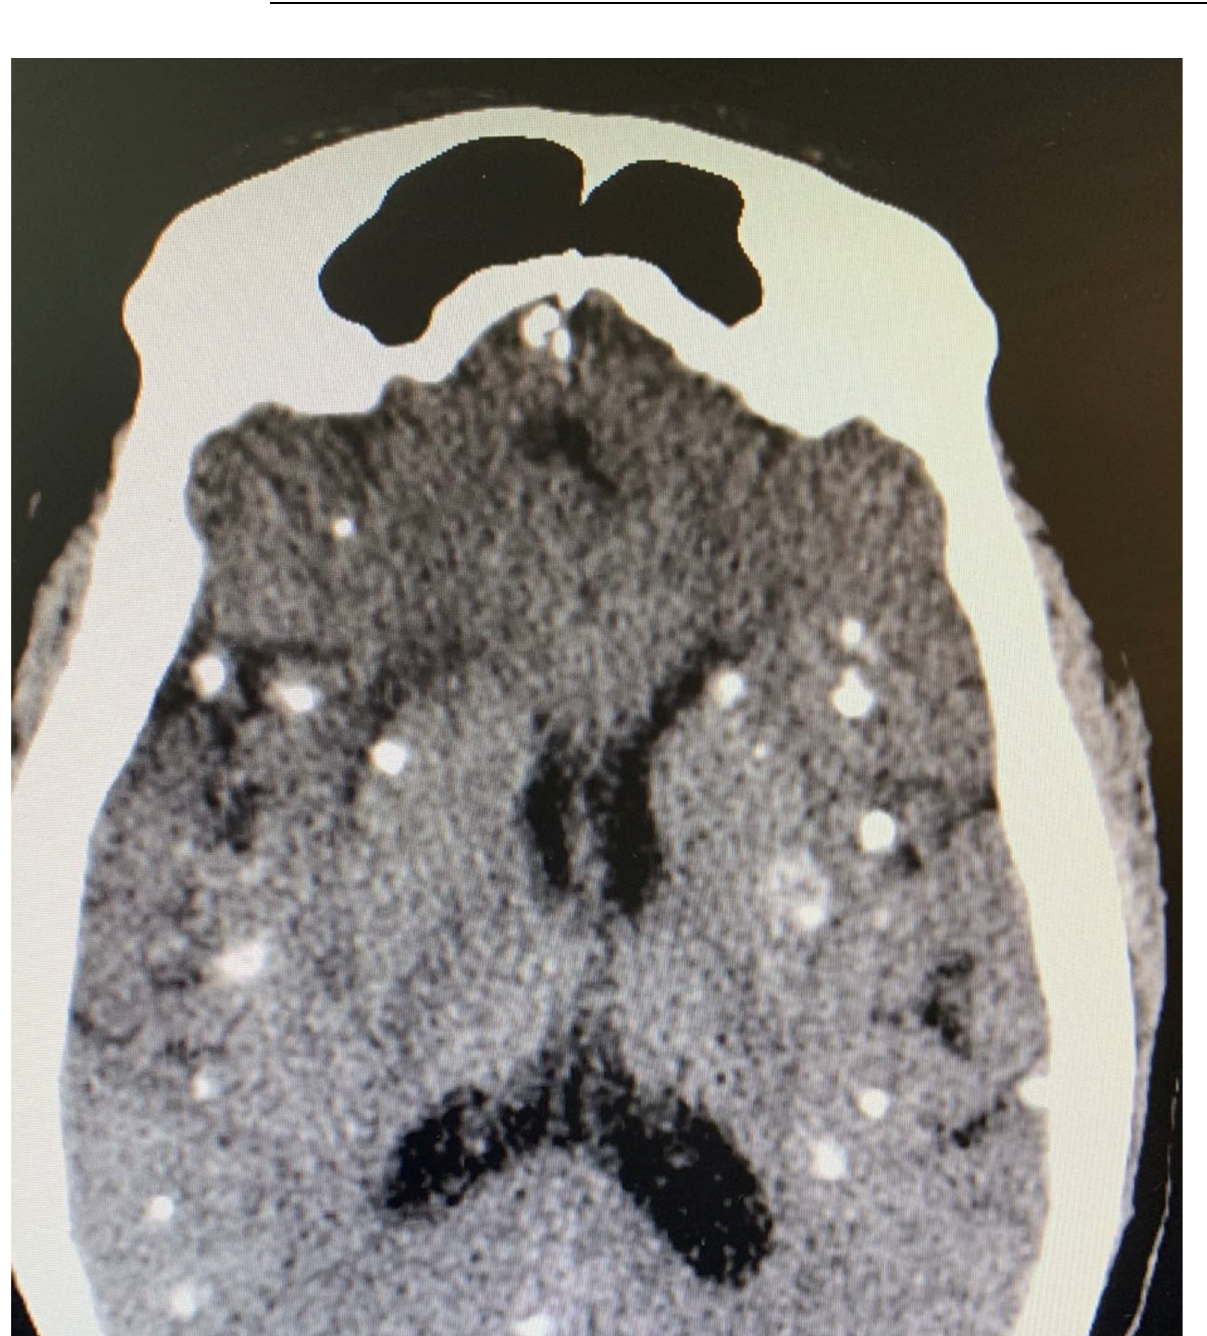
Figure 2. Head CT scan showing multiple cysticerci in the cerebral cortex.